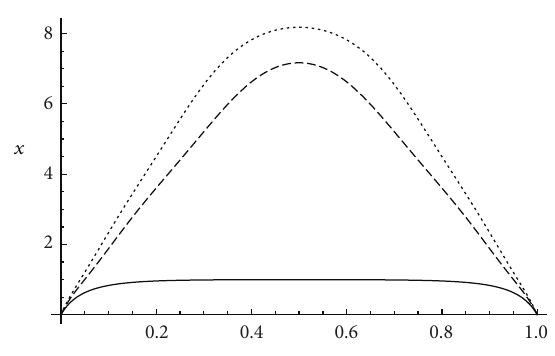
Figure 6: The solution of problem (15), (10), 𝛼 ≈ 17.0132 .